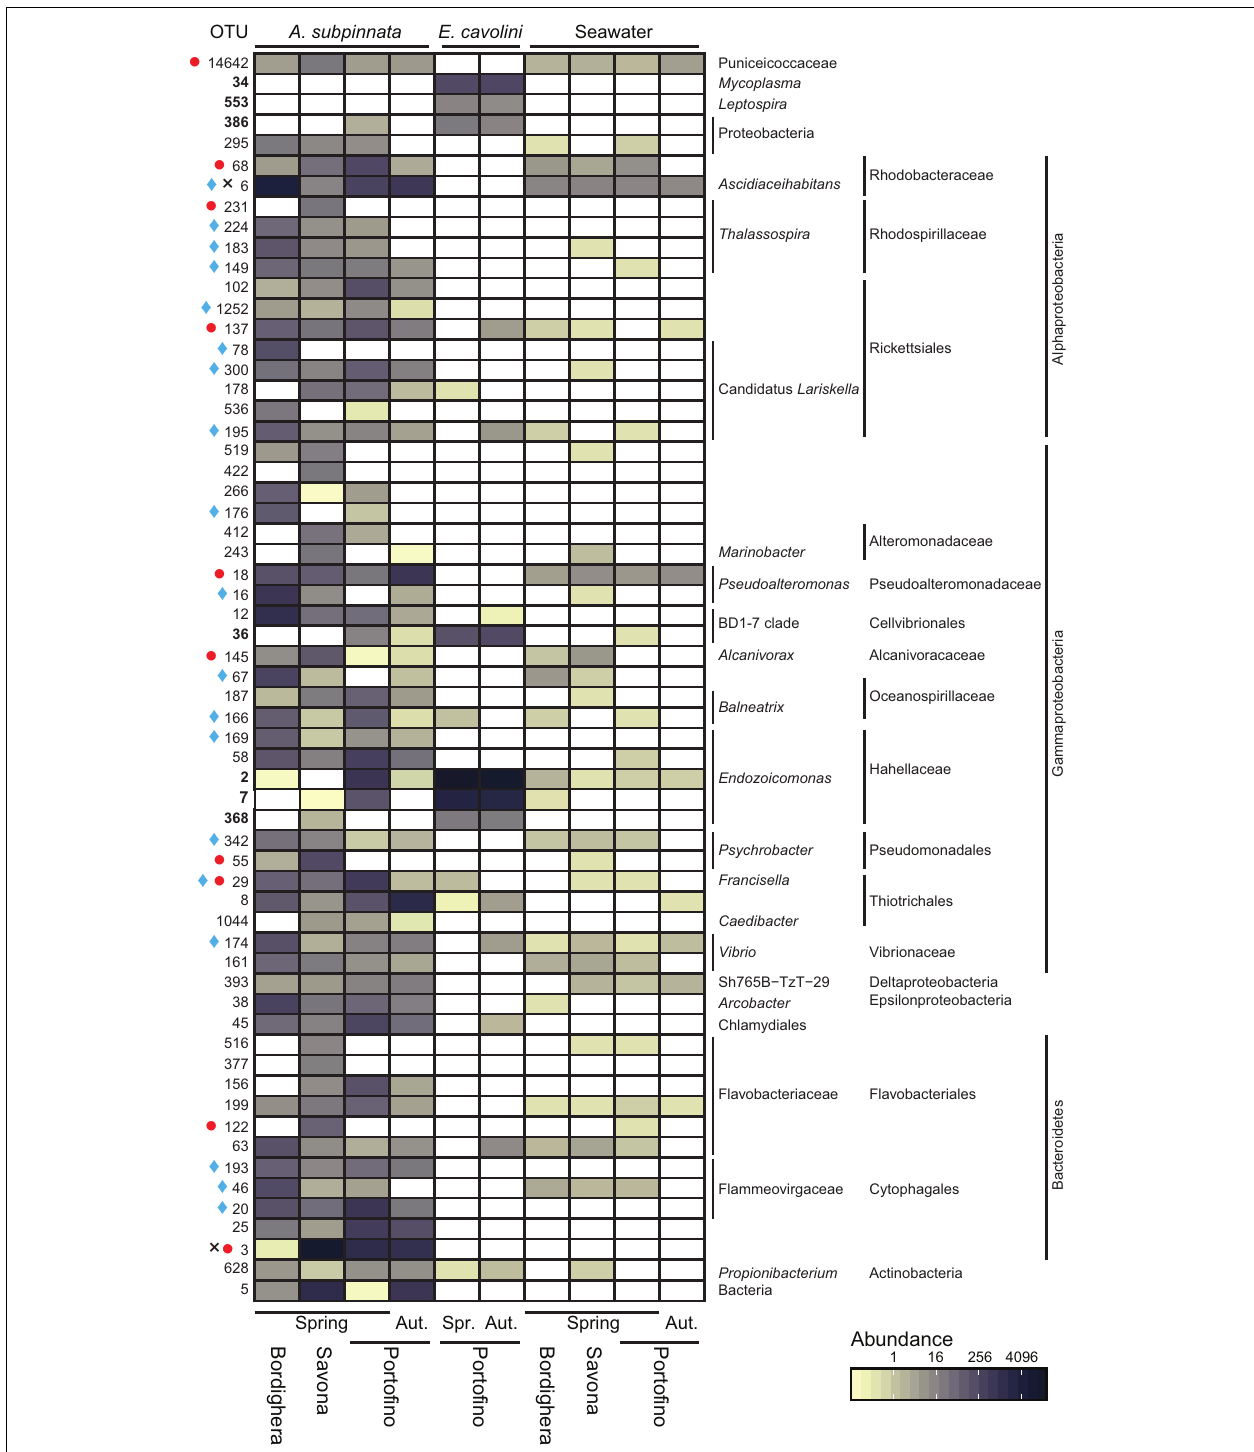
FIGURE 5 | Core and locally stable microbial associates of Antipathella subpinnata and Eunicella cavolini and their presence in the surrounding seawater. Heatmap presents the abundance of OTUs considered as part of the core microbiome (present in all samples of a species) and locally stable microbial associates (LSMA, present in at least 80% of the samples from one location). OTUs indicated in bold are core microbes of E. cavolini. LSMA OTUs indicated with a symbol are present in all samples of A. subpinnata at a given location: Bordighera ( (cid:7) ), Savona ( • ) and Portofino ( × ) in spring (Spr., April/May 2017) and autumn (Aut., November 2016). The taxonomy of each OTU is given at lowest possible taxonomic level. OTUs presented have a higher relative abundance in A. subpinnata than seawater. See Supplementary Figure S3 for OTUs with equal or lower relative abundance in A. subpinnata than seawater.